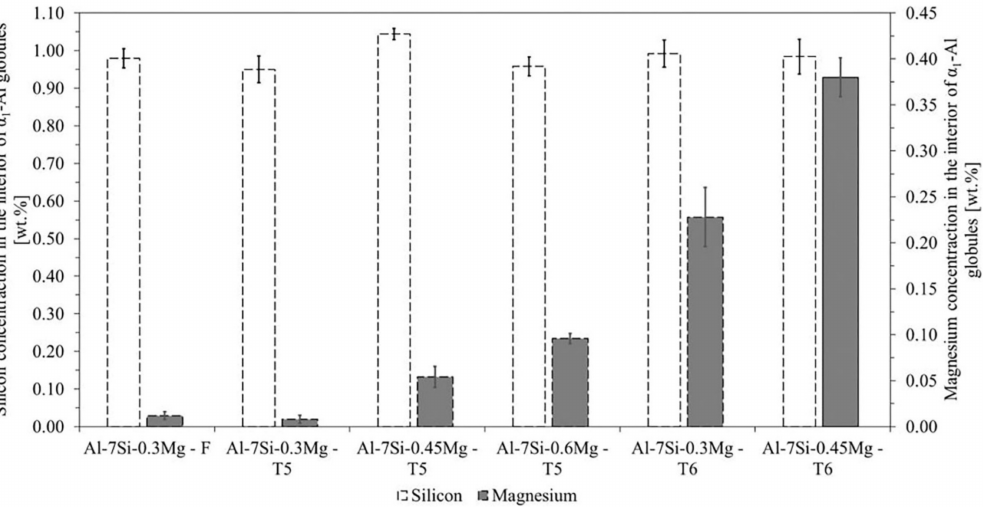
Figure 10. Silicon and magnesium concentrations in the interior of α 1 -Al globules obtained for the di ff erent SSM castings. Error bars show the standard deviation of the